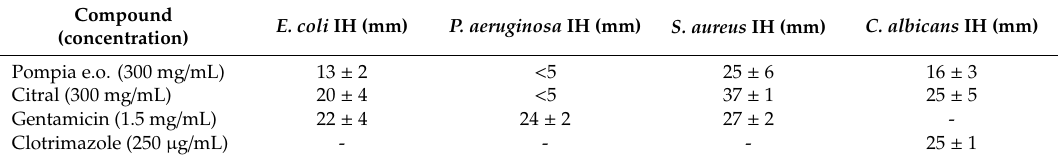
Table 3. Inhibition halo (IH) provided by pompia essential oil, citral, gentamicin and clotrimazole against E. coli , P. aeruginosa , S. aureus , and C. albicans . Mean values ± standard deviations (n = 4) are reported.